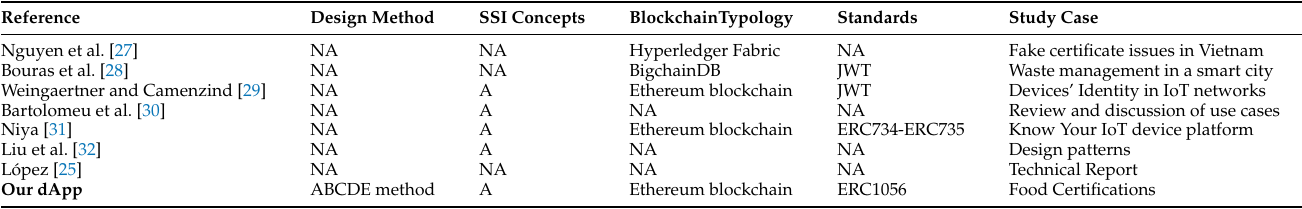
Table 1. A comparative table of related